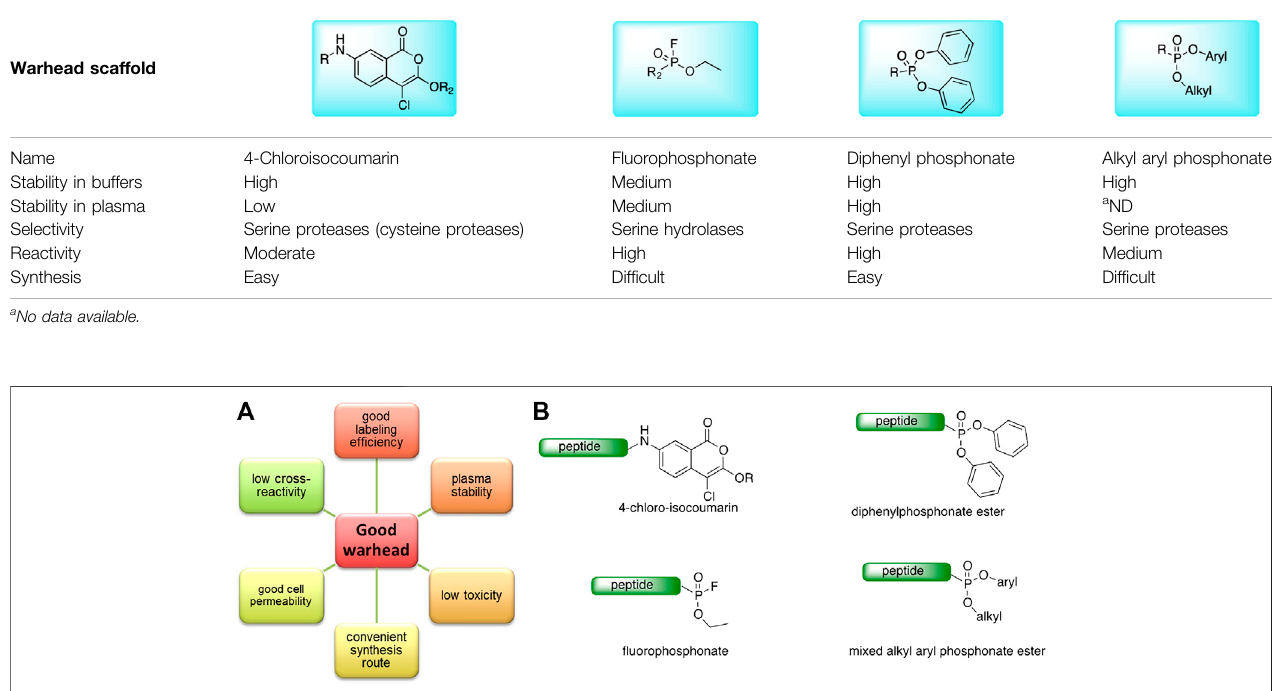
TABLE 2 | Serine protease reactive groups and their characteristics.